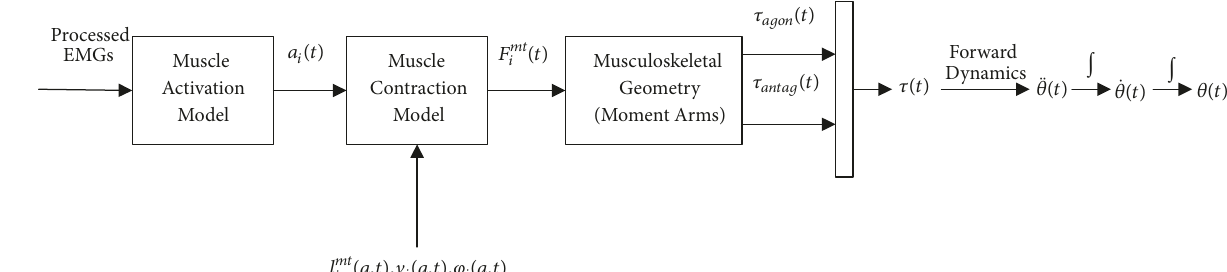
Figure 2: The sEMG-driven musculoskeletal model